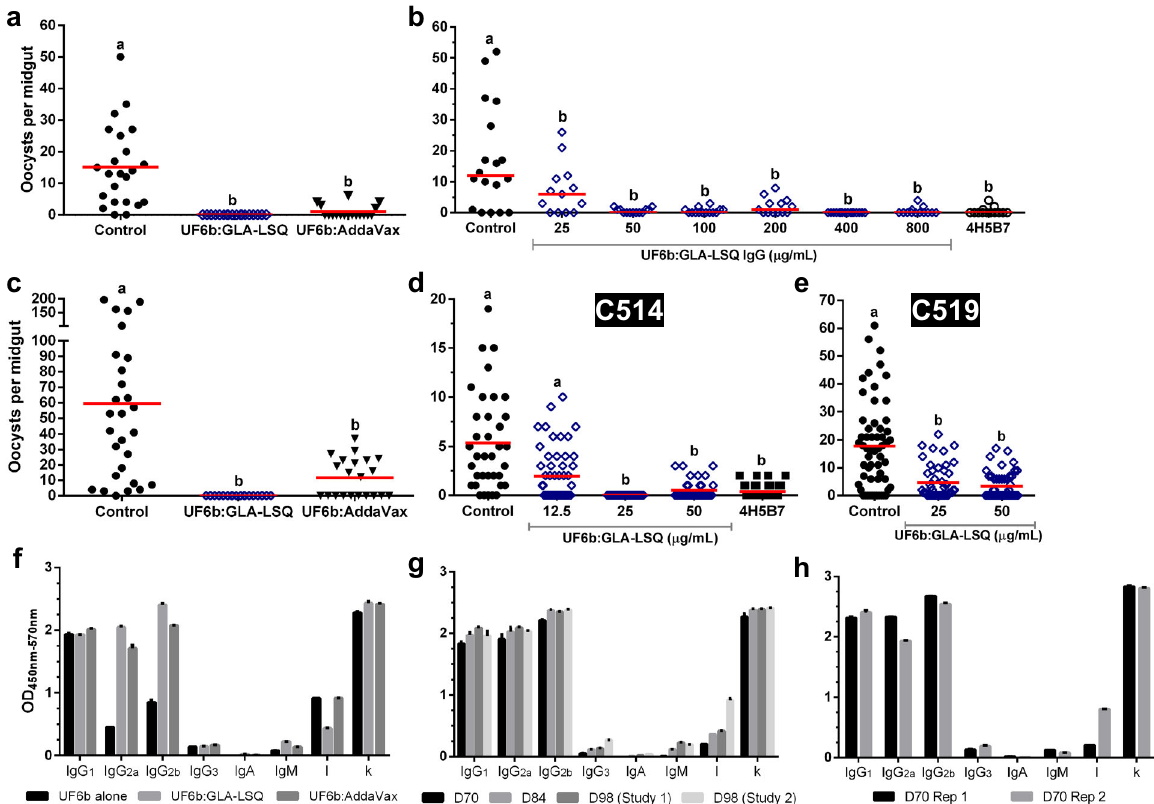
Fig. 4 Functional activity of UF6b antibodies. a – e UF6b:GLA-LSQ generates potent transmission-blocking antibodies against both lab and naturally circulating Plasmodium strains. a Representative standard membrane feeding assay (SMFA) using 50 µg/mL total IgG puri fi ed from pooled sera of mice immunized with UF6b collected on Day 98. b Representative SMFA using serial dilutions of puri fi ed IgG from Day 70 of the 98-Day study. The monoclonal antibody (mAb) 4H5B7 was included at 250 µg/mL as a positive control. c Representative SMFA in the presence of an increased parasite oocyst burden in mosquitoes ( X ̄ = 60) in the control group as compared to a representative lower midgut oocyst burden as shown for panel ( a ) controls ( X ̄ = 15) using 50 µg/mL total IgG puri fi ed from pooled sera of mice immunized with UF6b collected on Day 98. d - e Direct membrane feeding assay (DMFA) in Cameroon conducted with blood from 2 gametocytemic children (Case codes C514 and C519) with varying concentrations of total IgG. The peptide 7 mAb 4H5B7 served as the positive control. a – e Total IgG was puri fi ed from the same cohort of mice. Treatments without a common letter were found to be statistically signi fi cant ( α = 0.05, p < 0.01, N = 14 – 59) as calculated by Kruskal – Wallis test with Dunn ’ s post hoc correction or by zero-in fl ated Generalized Linear Mixed Model as appropriate. Red horizontal bar indicates mean oocyst number per mosquito midgut. Mosquito sample sizes for each control/test group from left to right: ( a ) 39, 43, 46 ( b ) 18, 13, 13, 14, 13, 16, 13, 13 ( c ) 23, 18, 18 ( d ) 36, 54, 44, 40, 48 ( e ) 58, 48, 50. f Comparison of Ig isotypes present in antisera from the 98-Day study between UF6b alone, UF6b:GLA-LSQ and UF6b:AddaVax ™ . g Comparison of Ig isotypes from collections at D70, D84, and D98 from the 98-Day studies. h Ig isotypes for two replicates of the 70-Day studies. f – h Sera used at 1:1,000 dilution. Error bars indicate the SEM for replicate wells. See text for